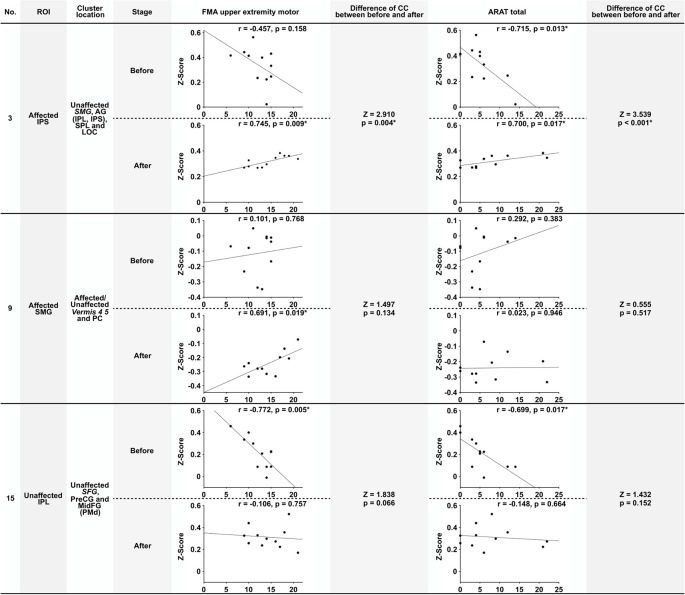
Scatter plots of significant correlation in Table 5, and the results of testing the significance of the correlation coefficient. This figure shows the scatter plots of the significant correlations shown in Table 5. The number (No), ROI name, and cluster location name of Columns are associated with Tables 4, 5. Stage means the assessment stage before and after the intervention. The correlation coefficient (r) and the probability value (p) shows above the scatter plot. The column of “Difference of CC (correlation coefficient) between before and after” shows the result of testing of the significance of the correlation coefficient (Z, Z-score; p, probability value). The significance probability defined p = 0.05/6 because a total of six tests were required. Values were marked *if they were below this threshold. Abbreviations: FMA upper extremity motor, the score of Fugl-Meyer assessment upper extremity motor function; ARAT total, Total score of Action research arm test; SMG, supramarginal gyrus; AG, angular gyrus; SPL, superior parietal lobule; MidFG, middle frontal cortex; PreCG, precentral gyrus; PC, cingulate gyrus posterior division.